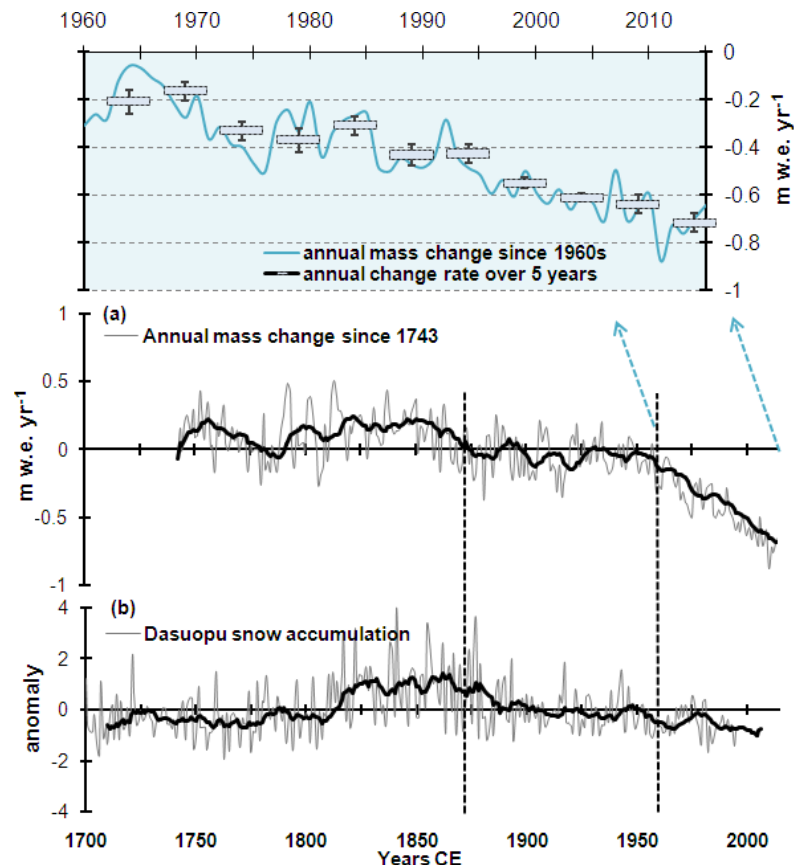
Figure 2. (a) Reconstructed glacier mass balance for the western central Himalaya (WCH) since 1743CE (coloured inset indicates annual and pentadal mass change rate since the 1960s with SEs). (b) Annual snow accumulation record derived from Dasuopu ice core from the eastern central Himalaya (Thompson et al., 2000). Dark lines indicate 11-year moving averages. Vertical dashed lines are results of break-point analyses that reveal three major phases in the